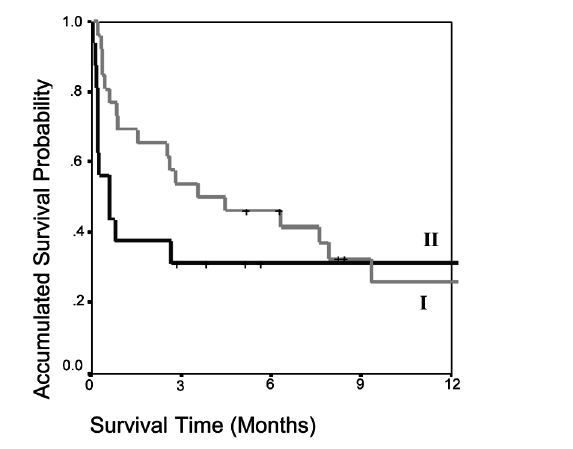
Figure 4 – Survival of patients with previously diagnosed neo- plasia (I), or neoplasia diagnosed during assessment for nephrostomy (II), p = 0.27.